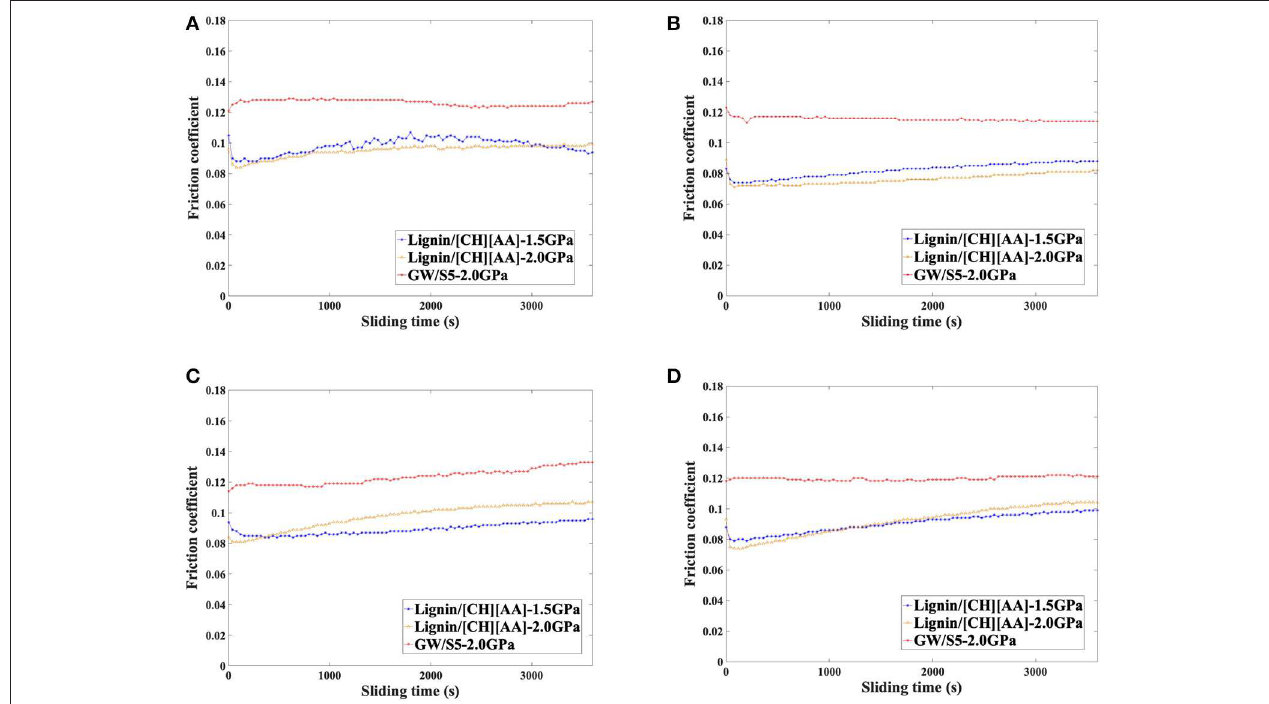
FIGURE 2 | Friction behavior of each disc: (A) steel disc, (B) Tribobond 40 disc, (C) Tribobond 43 disc, (D) Tribobond 44 disc.